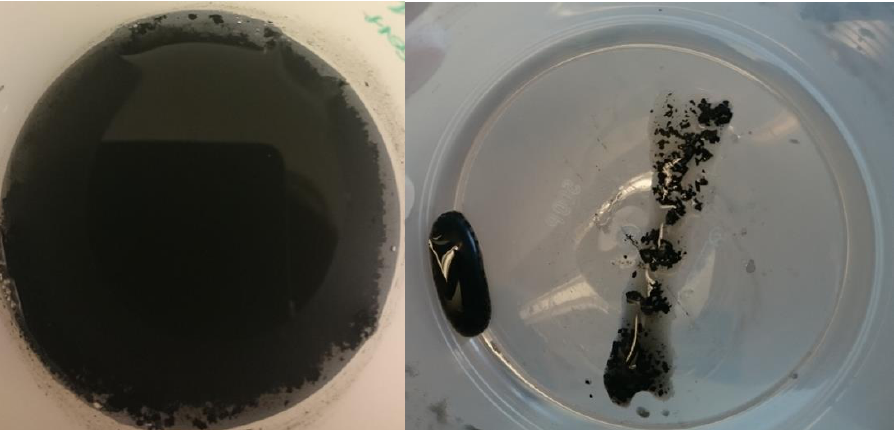
Figure 2. Appearance of chunks of CNT agglomerates in Nanocyl suspension ( left ) and Nanolab suspension ( right ) after three hours of deposition; suspensions were taken from the electrophoretic deposition (EPD) bath and placed on a 100-mm diameter disc for better observation and photographs.